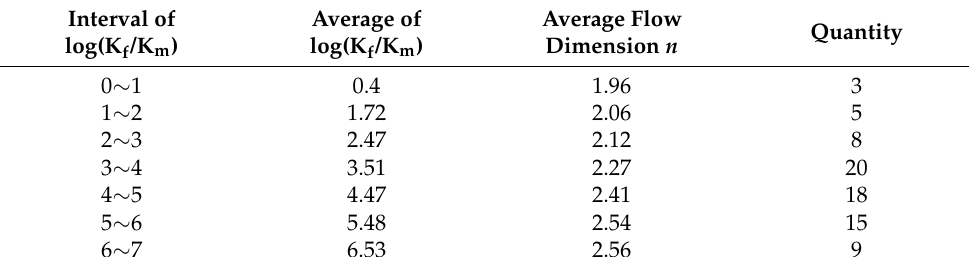
Table 6. Results for grouping K f /K m data.